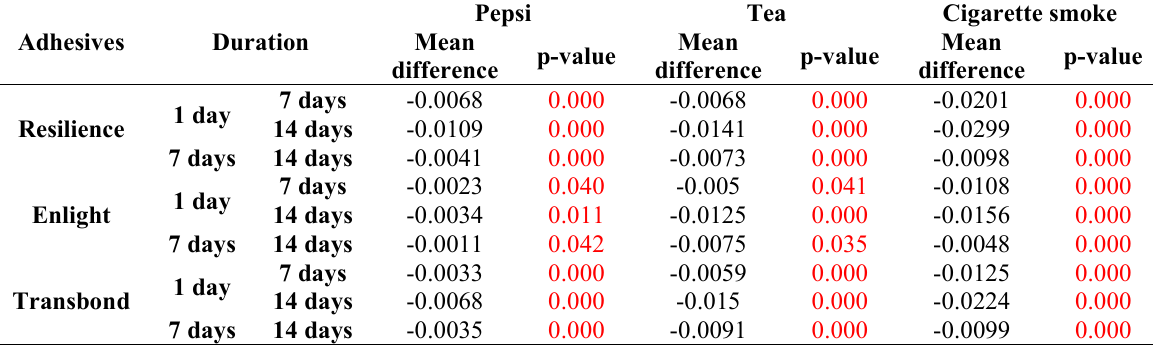
Table 4: Difference in the amounts of light absorption according to the immersion days of sapphire bracket in the staining